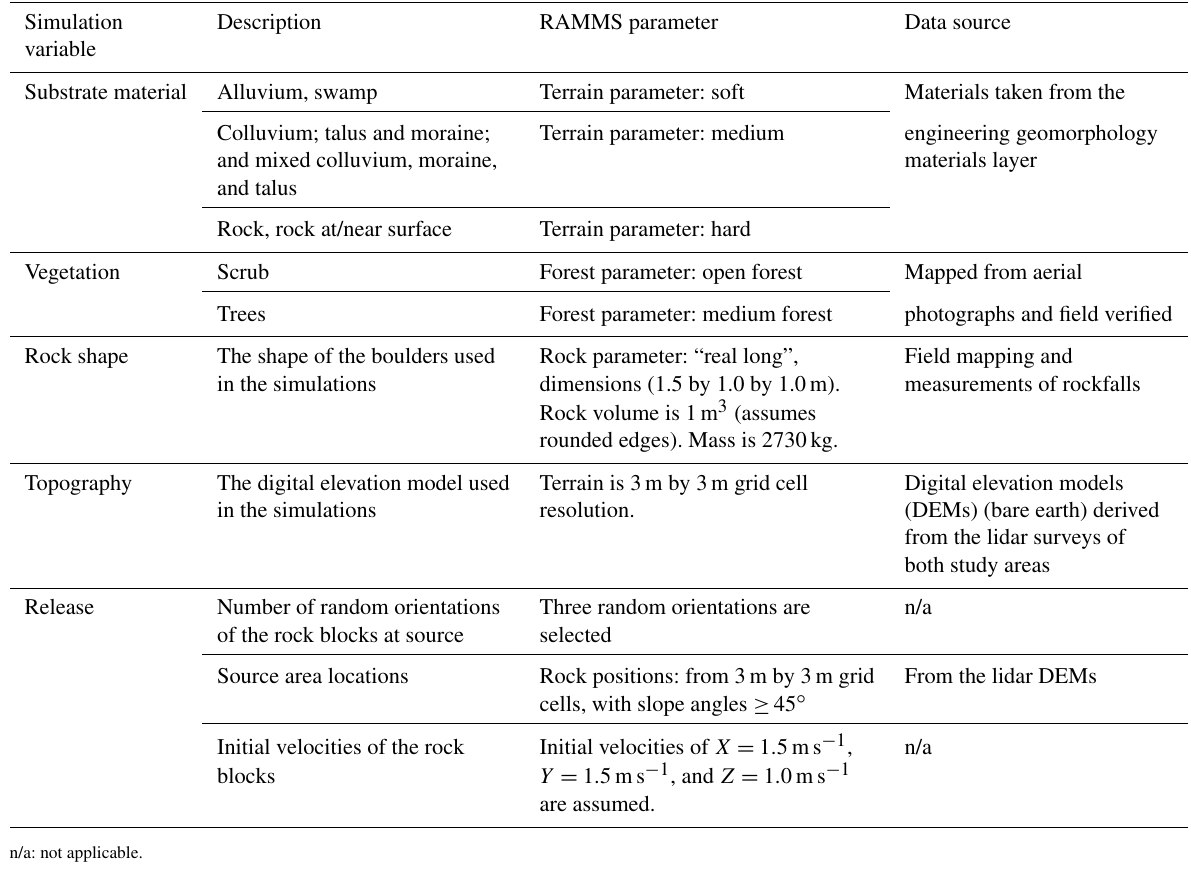
Table C1. RAMMS rockfall model parameters used for forecasting rockfalls.